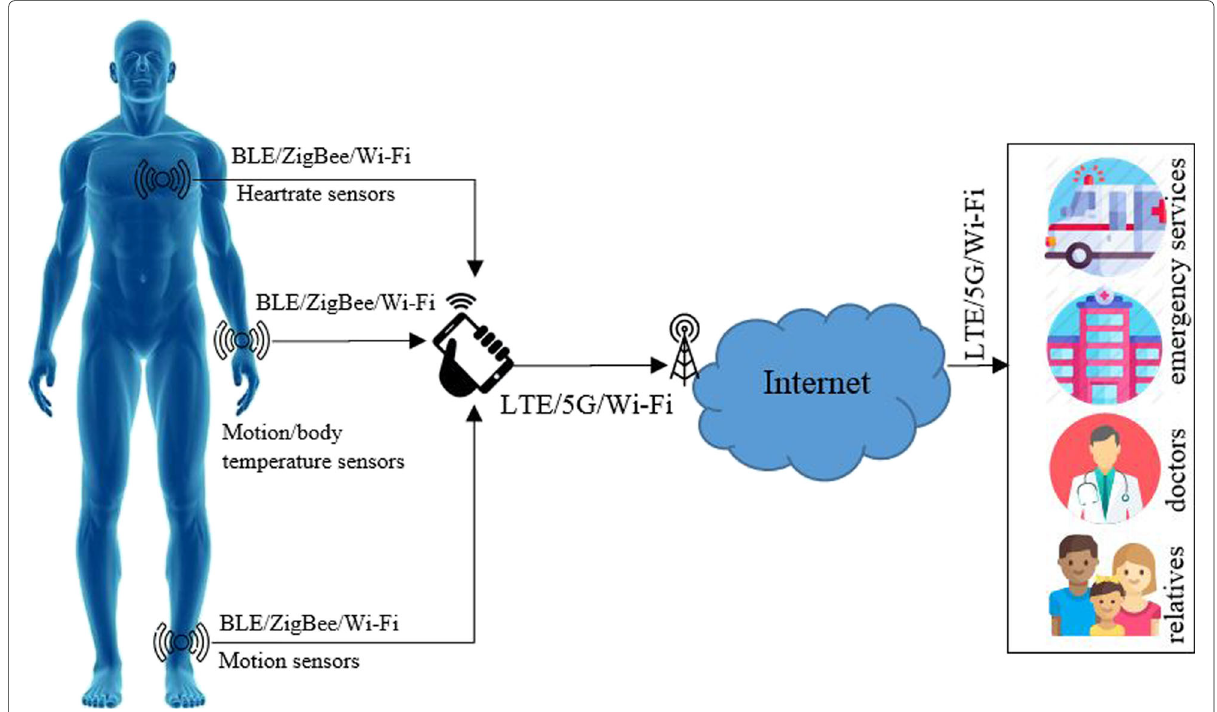
Fig. 1 Role of communication technologies in IoT-based eHealth